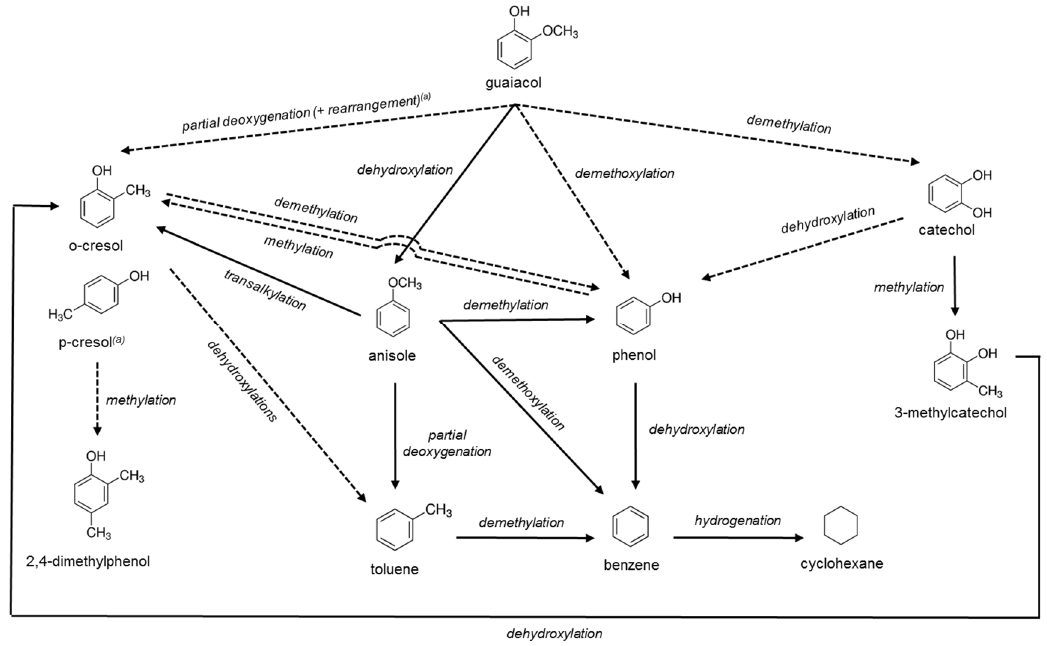
Figure 4. Scheme of the possible reaction pathways during the hydrodeoxygenation of guaiacol over the Mo 2 C/CNF catalysts at 573 K (dashed lines) and at 623 K (dashed and solid lines) (adapted from [2,10,13,46–52]). Catalysts 2018 , 8 , x FOR PEER REVIEW